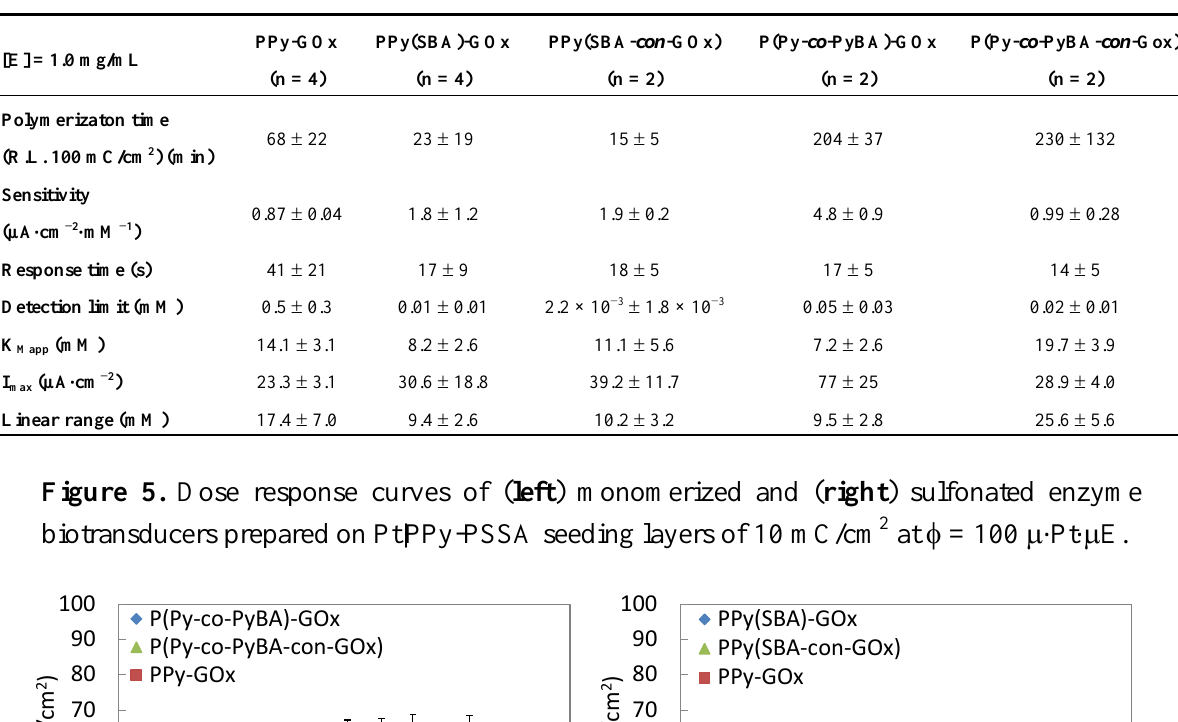
Table 1. Dose response (PBS, pH = 7.2, 25 °C) performance parameters for biotransducers fabricated with (10:1 ratio PyBA/SBA:GOx) covalently modified enzymes, non-covalently modified enzymes and control systems having no modification (±standard deviation is shown).